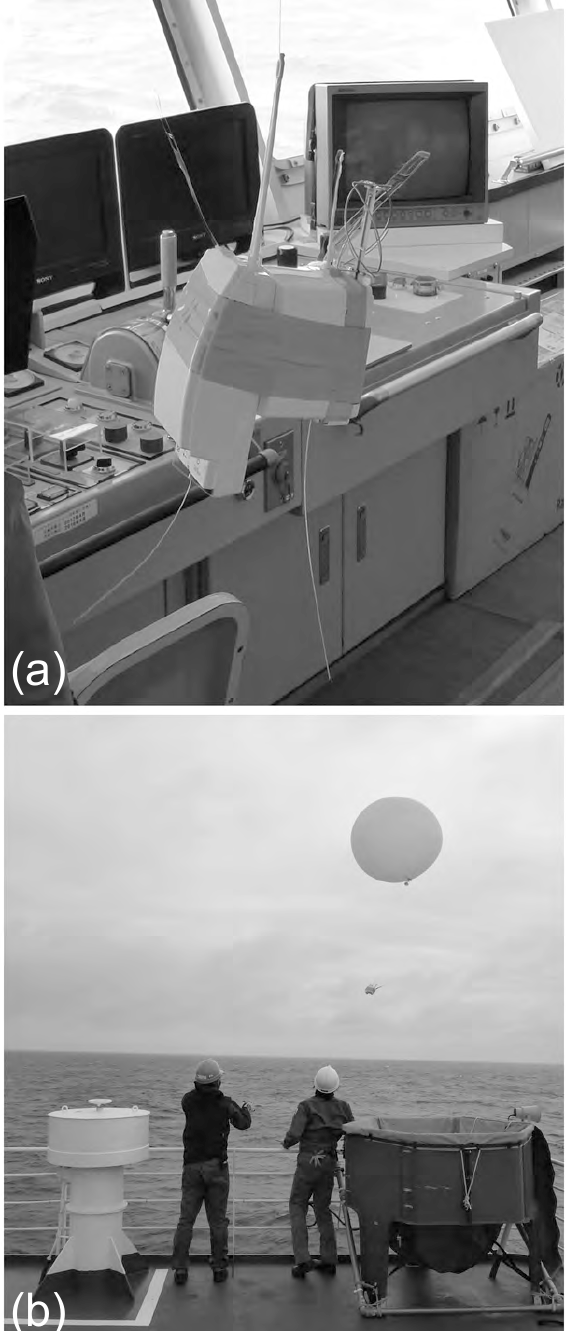
Figure 2. Photographs of (a) the RS92 and RS41 radiosondes di- rectly attached to each other and (b) a launch on R/V Mirai .